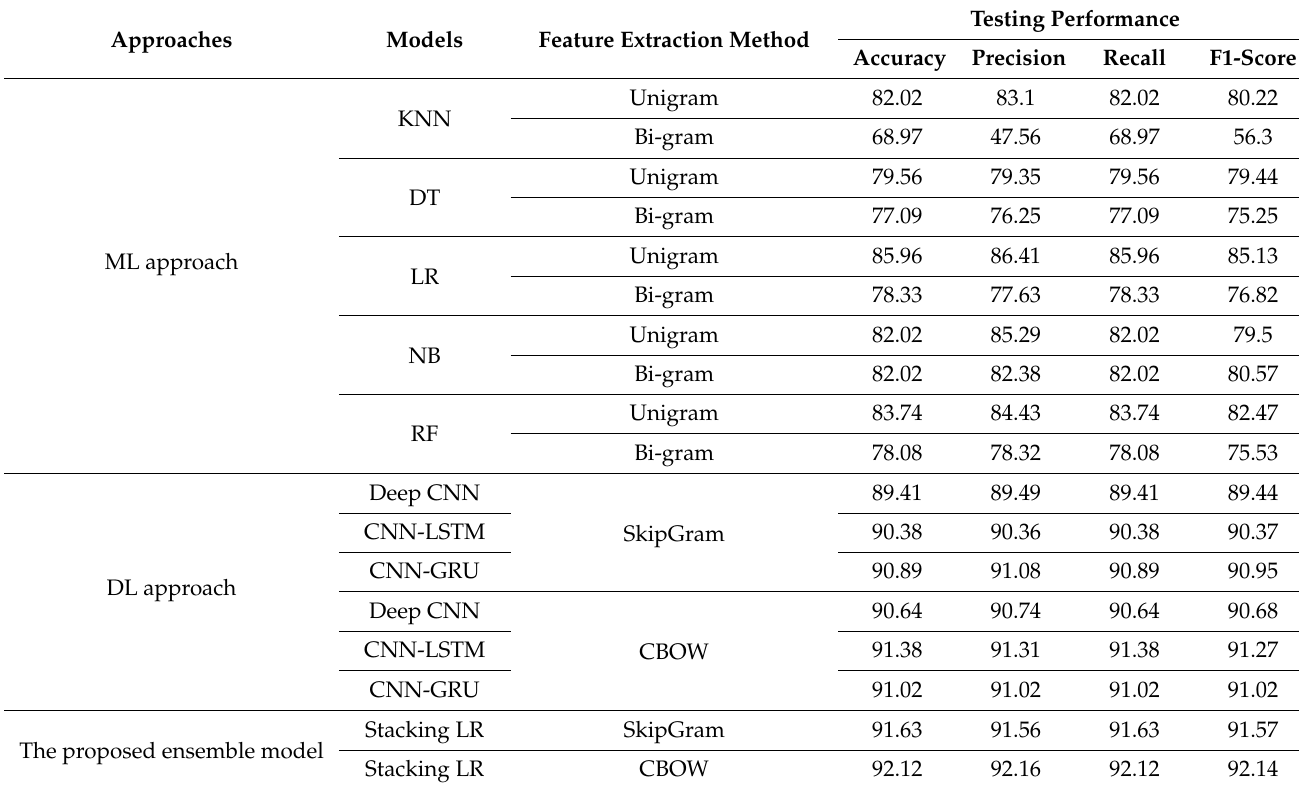
Table 4. The performance results of models for the Main-AHS